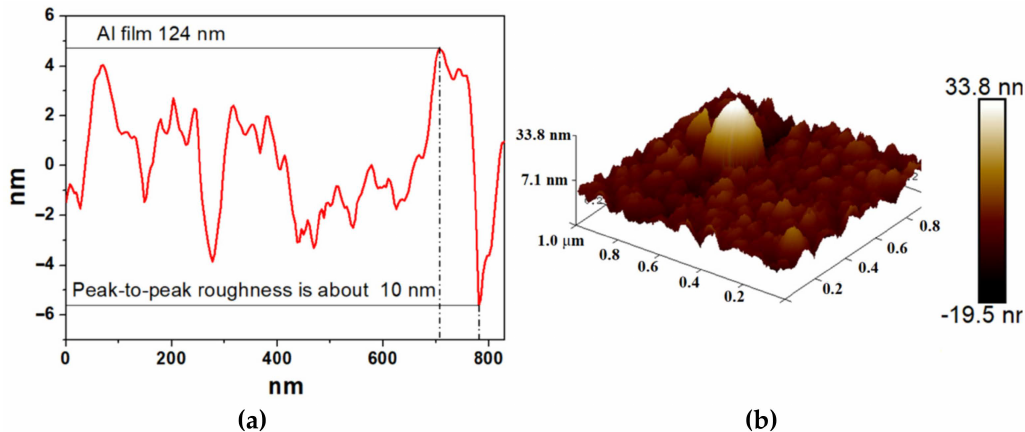
Figure 1. ( a ) Surface profile for Al film of 124 nm thick; peak-to-peak roughness is approximately ± 5 nm. ( b ) AFM image. Lateral grain size is comparable to film thickness. The largest grain in 3d view is 40 nm high. Al films were fabricated by electron beam